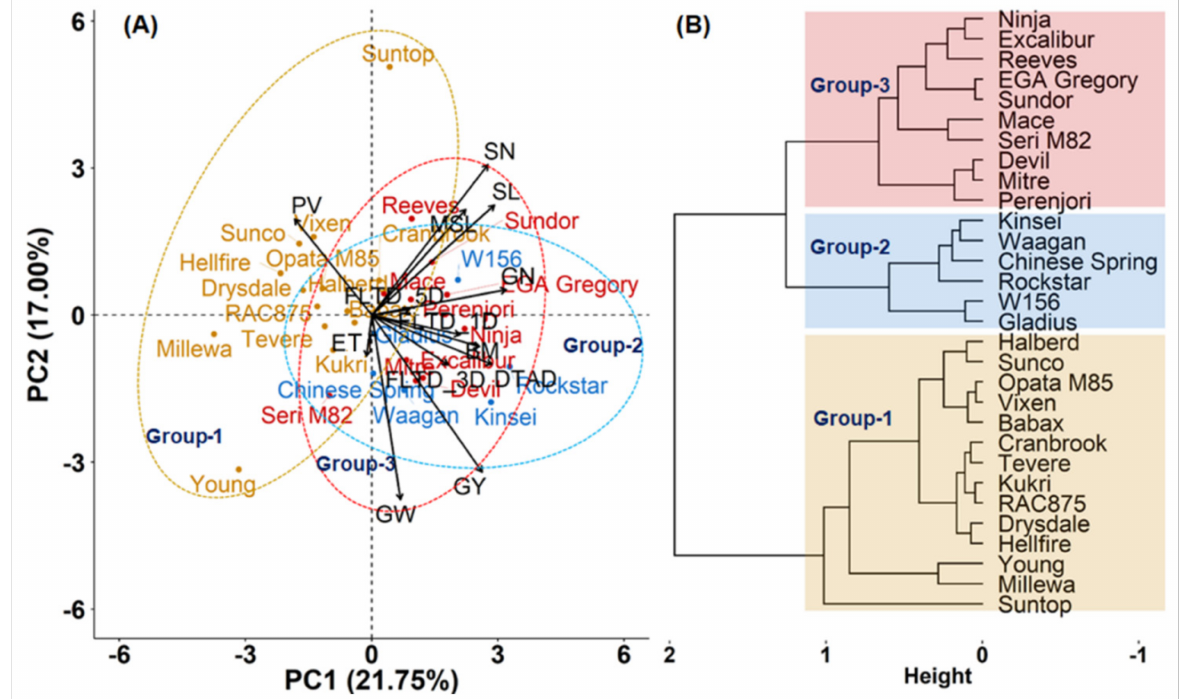
Figure 4. ( A ) Principal component analysis (PCA) biplot of 30 wheat cultivars and the measured variables/traits (% reduction under high temperature relative to the control temperature treatment); length of arrows indicates the relative size of contribution of the trait, and direction of arrows indicates impact on variety response to traits in the PCA, ( B ) Hierarchical cluster diagram of varieties (Euclidean distance and Ward’s method). Varieties formed three clusters or groups as shown in ( A ) and ( B ) Group 1 includes ‘tolerant’ cultivars with a low percent reduction in yield, yield-associated traits and FLTD_5D under high temperature relative to control treatment. Group 2 includes ‘sensitive cultivars’ with higher reduction in GN, GY, GW, FLTD_1D and FLTD_3D under high temperature relative to control treatment. Group 3 includes ‘sensitive cultivars’ with higher reduction in GN, BM and FLTD_1D under high temperature relative to control treatment. Group 1 had the greatest relative reduction in PV. Abbreviations: GN, grain number (main stem); GY, grain yield (main stem); GW, average individual grain weight (main stem); SL, spike length (main stem); SN, spikelet number (main stem); MSL, main stem length; PV, pollen viability (main stem); BM, above-ground biomass; ET, percentage effective tillers; FLTD_1D, flag leaf temperature depression day 1; FLTD_3D, flag leaf temperature depression day 3; FLTD_5D, flag leaf temperature depression day 5; DTAD, days from sowing to auricle distance 1